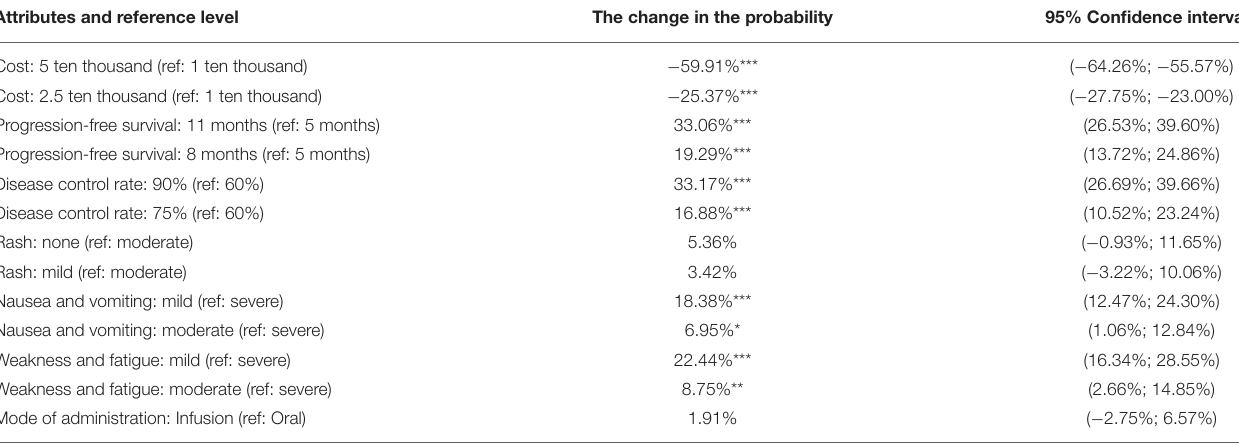
TABLE 7 | Simulated preferences for treatment under various potential treatment